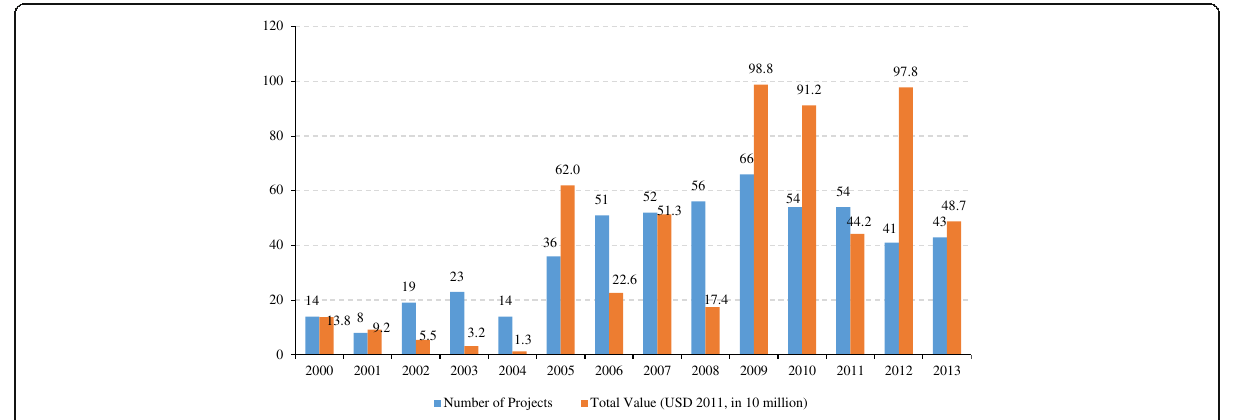
Fig. 2 Number and total value of public health projects between 2000 and 2013